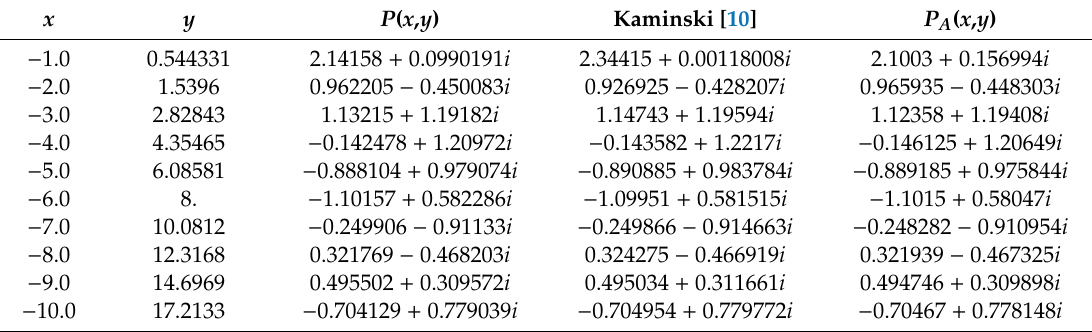
Table 4. Comparison of values of P ( x , y ) on the caustic with Kaminski [16] and P A ( x , y )